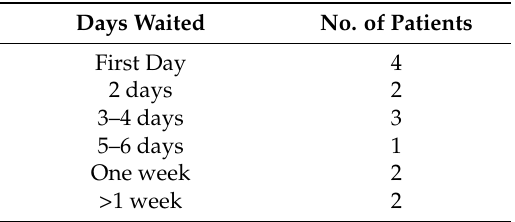
Table 3. Length of time patient waited before visiting the